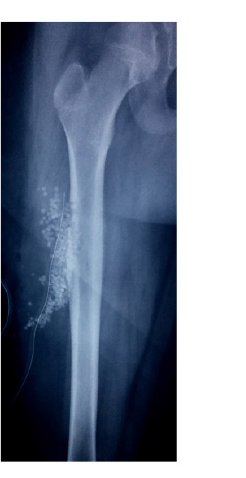
Figure 10. Pre operative radiograph of femur with intra medullary cement coated nail